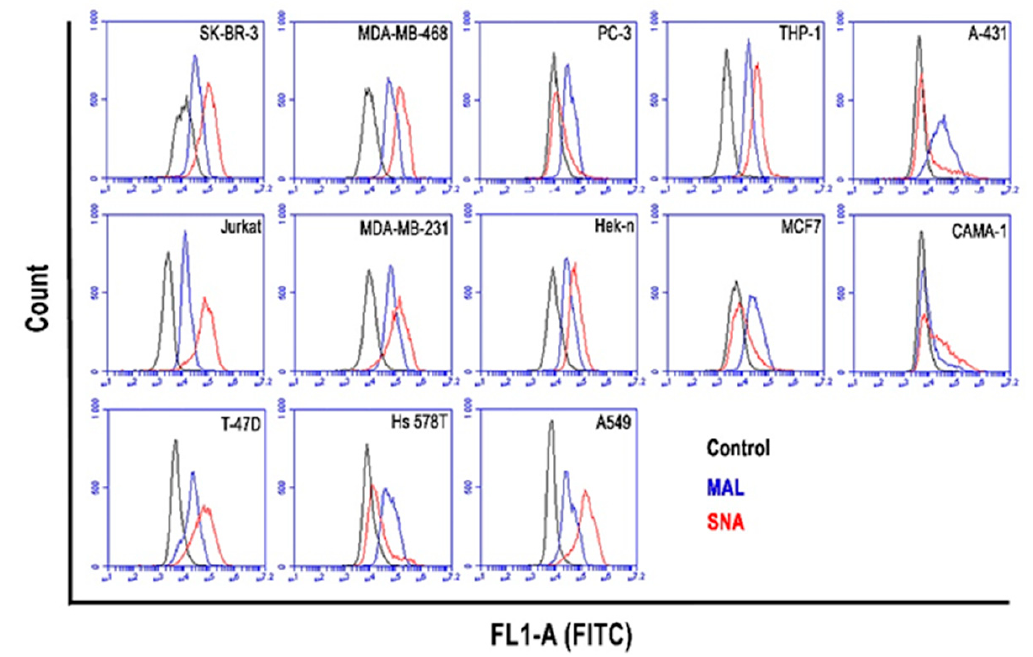
Figure 1. MAL I ( α 2,3-SA) and SNA ( α 2,6-SA) lectin binding to the thirteen cancer cell lines. Both lectins were used at a concentration of 5 µg/mL. The flow cytometry histograms show the mean fluorescence intensity (MFI) of unstained control cells (black lines) and lectin-stained cells (blue lines for MAL I and red lines for SNA). One representative experiment out of two performed is shown.